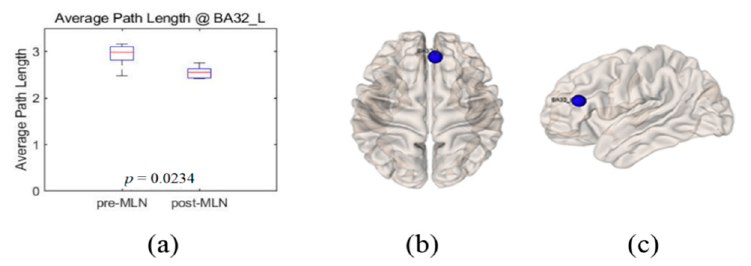
Figure 4. Illustrations of average path length change at left Brodmann areas 32_L as the functional connectivity of neural network in fibromyalgia patients’ brains due to Milnacipran drug therapy. ( a ) Boxplots (left: before medication, right: after medication) of the distribution of average path length at left Brodmann areas 32. Blue-colored markers indicate this location on the 3D brain surface in ( b ) transverse and ( c ) lateral views. Blue color markers imply that the average-path-length index statistically decreased due to drug therapy.